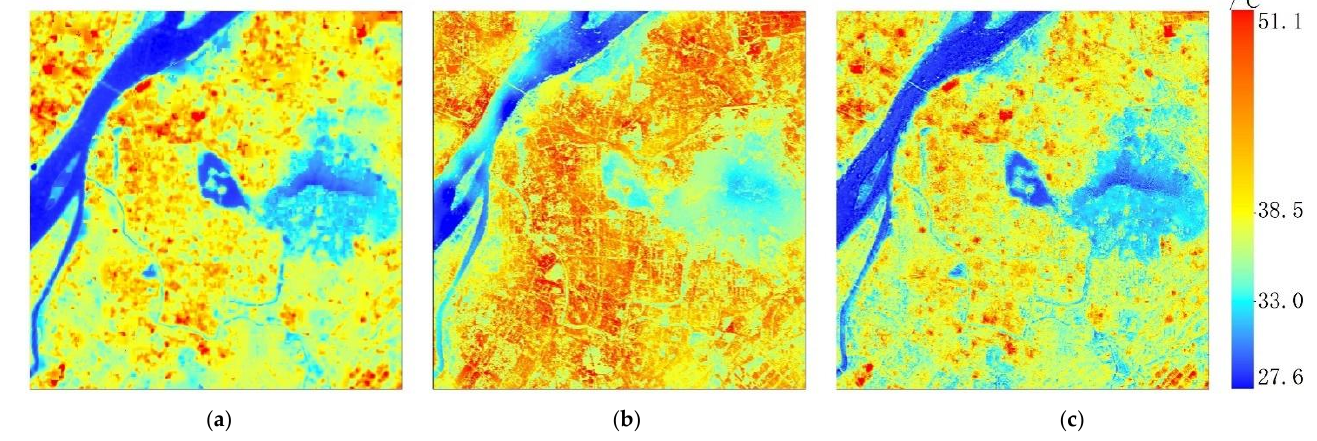
Figure 2. Spatial distribution of LST at 30-m spatial resolution. ( a ) Landsat reference LST. ( b ) Downscaled LST results of DRFD. ( c ) Downscaled LST results of SSRFD.